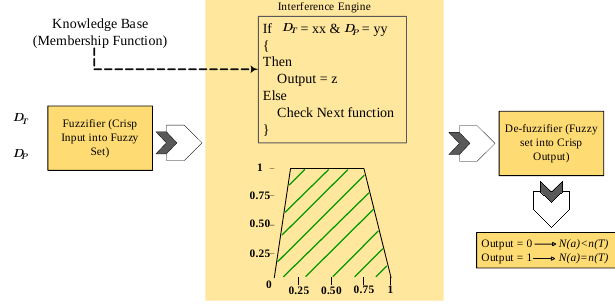
Figure 7. Fuzzy logic method in ABAC.